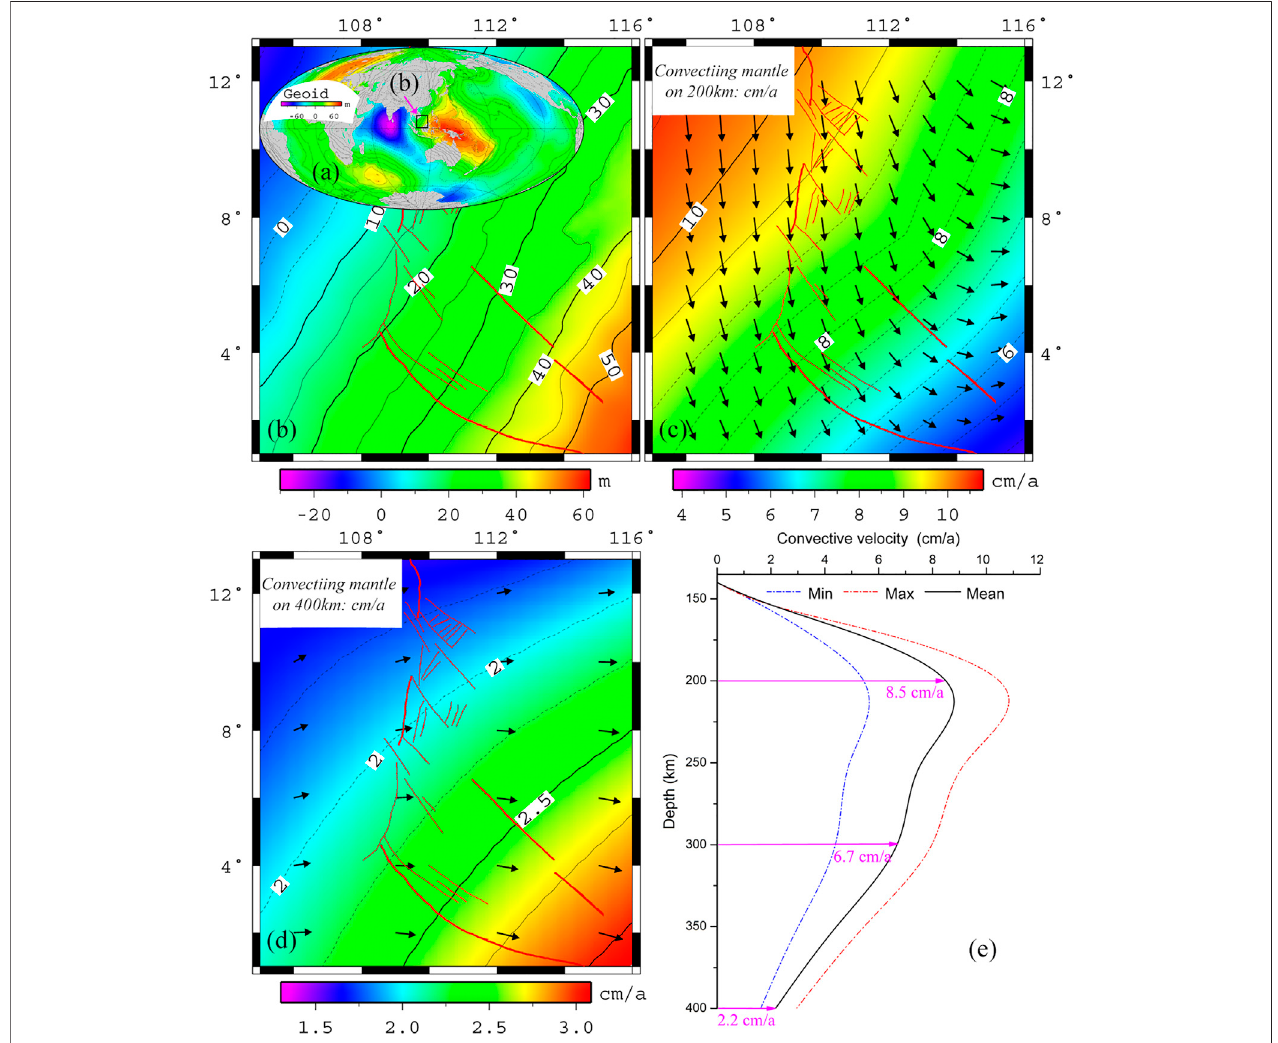
FIGURE 7 | Analysis of convection in the upper mantle asthenosphere of the southwestern margin of South China Sea (SCS). (A) Global geoid anomaly (m). (B) Geoid anomaly (m) in the southwestern margin of SCS. (C) Convective velocity of the mantle at 200-km depth (cm/a). (D) Convective velocity of the mantle at 400-km depth (cm/a). (E) Variation of convective velocity of the asthenospheric mantle with depth (cm/a).